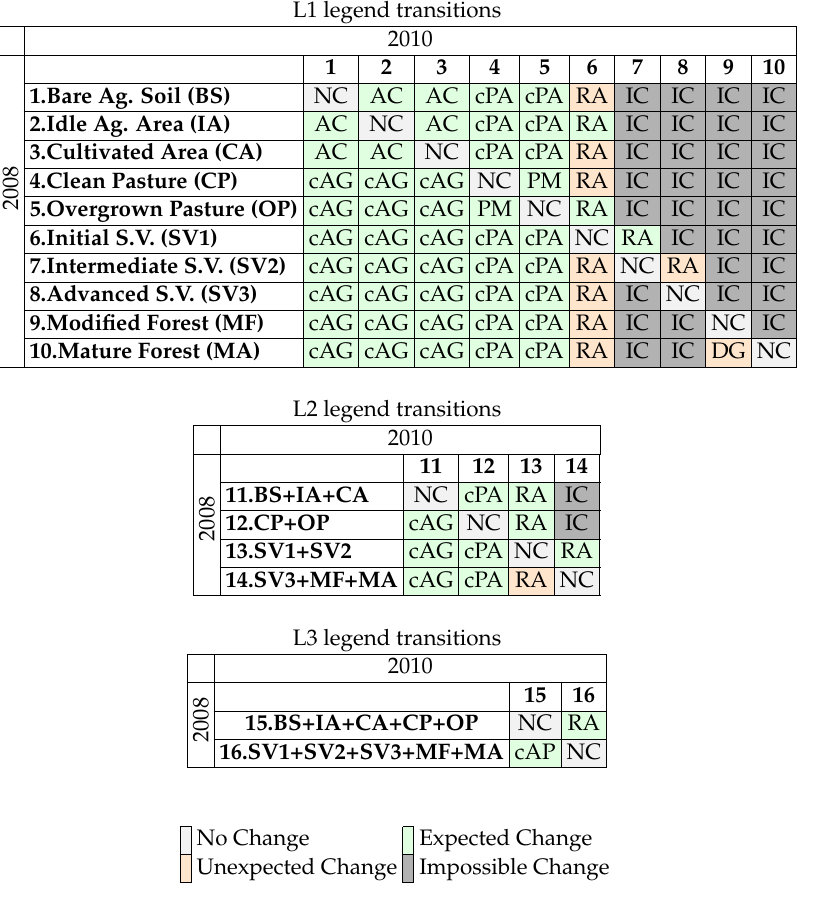
Figure 9. Collapsed change classes definition and likelihood of transitions. Notes: Ag. = Agricultural and S.V. = Secondary